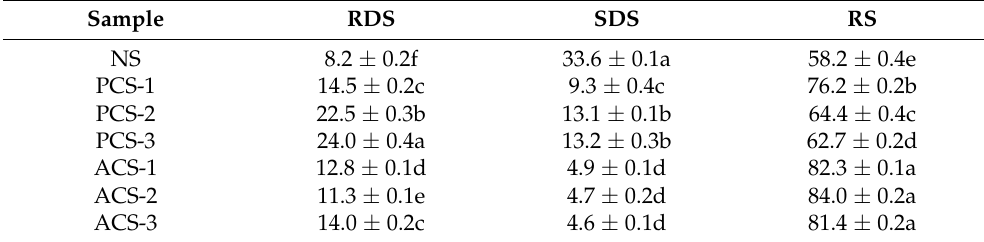
Table 5. Englyst digestion profiles of starch fractions from native, phosphorylated and acetylated chestnut starch (excluding free glucose, g/100 g).